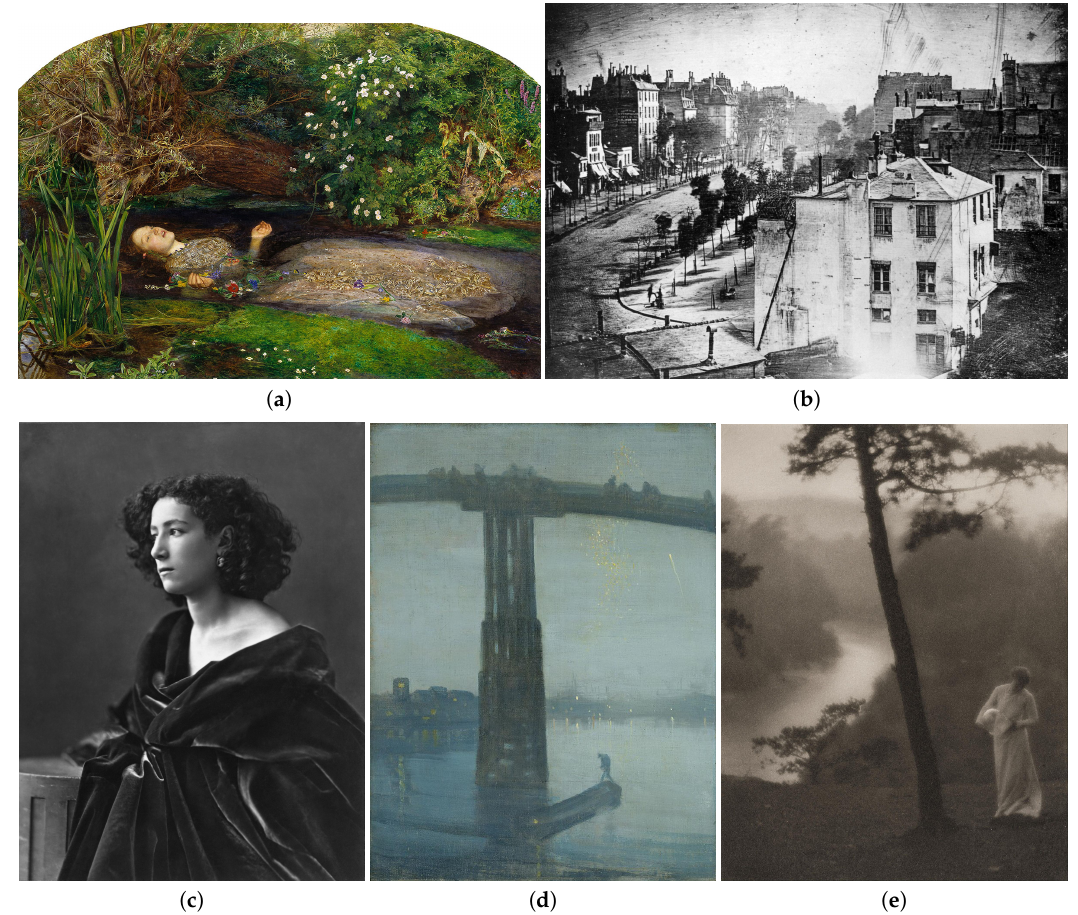
Figure 1. The interplay of painting and early photography. ( a ) By the 19th century, Western painters had achieved dazzling levels of realism. ( b ) Early cameras took low-quality (though evocative) pictures. This daguerreotype took over 10 minutes to expose. ( c ) However, camera technology steadily improved, capturing greater and greater realism, in much faster exposures. ( d ) This challenged painters to create works that were not about hyper-realistic depiction, such as Whistler’s Tonalist Nocturne . ( e ) The Pictorialist photographers attempted to establish photography as an art form by mimicking the styles and abstraction of painting. Works: ( a ) Ophelia , John Everett Millais, 1851; ( b ) Boulevard du Temple , Daguerre, 1838; ( c ) Portrait of Sarah Bernhardt , Félix Tournachon (Nadar), 1864; ( d ) Nocturne in Blue and Gold: Old Battersea Bridge , James MacNeill Whistler, c. 1872–1875; ( e ) Morning , Clarence H. White, 1908. Public domain